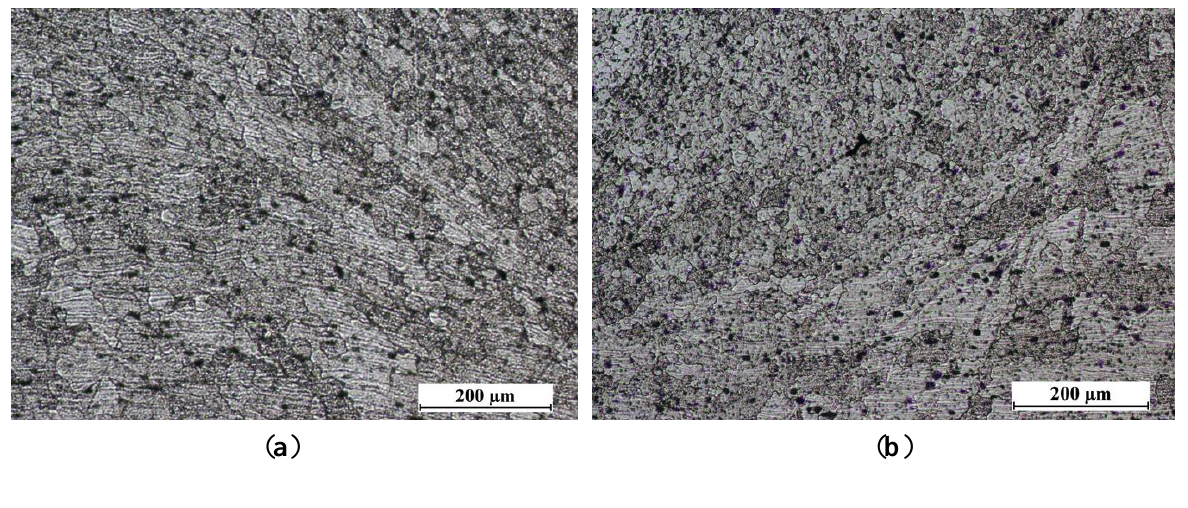
Figure 9. Transition zone in which HAZ and TMAZ are showed for ( a ) FSW; and ( b ) LAFSW welds (100× magnification).